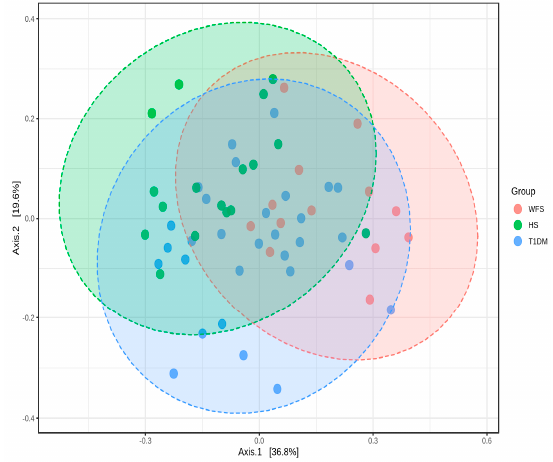
Figure 4. Two-Dimensional Principal coordinates analysis plot using bray distance. Statistical significance was evaluated by PERMANOVA F-value: 6.3631; p -value < 0.001.